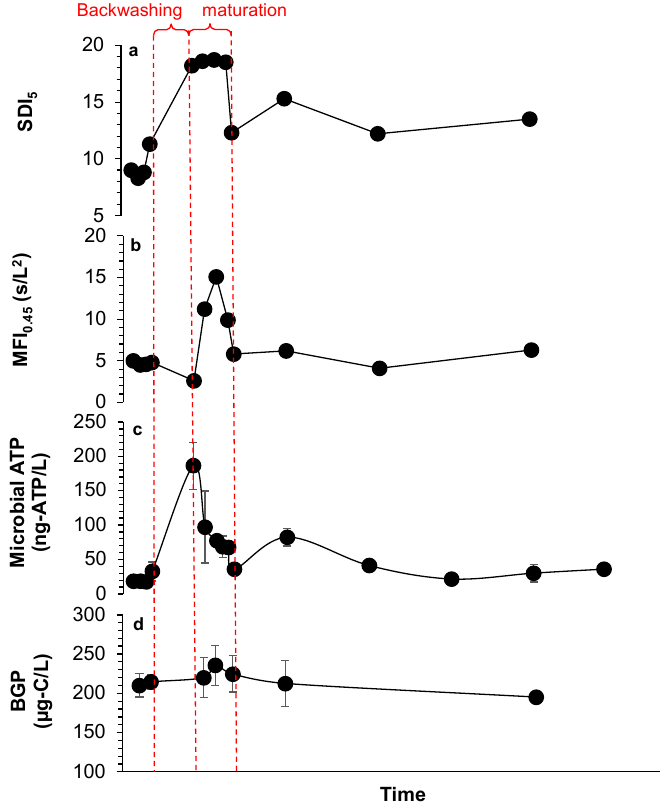
Figure 6. ( a ) SDI 5 , ( b ) MFI 0.45 , ( c ) microbial ATP and ( d ) BGP measured before and after backwashing in the first stage of a dual media filter.